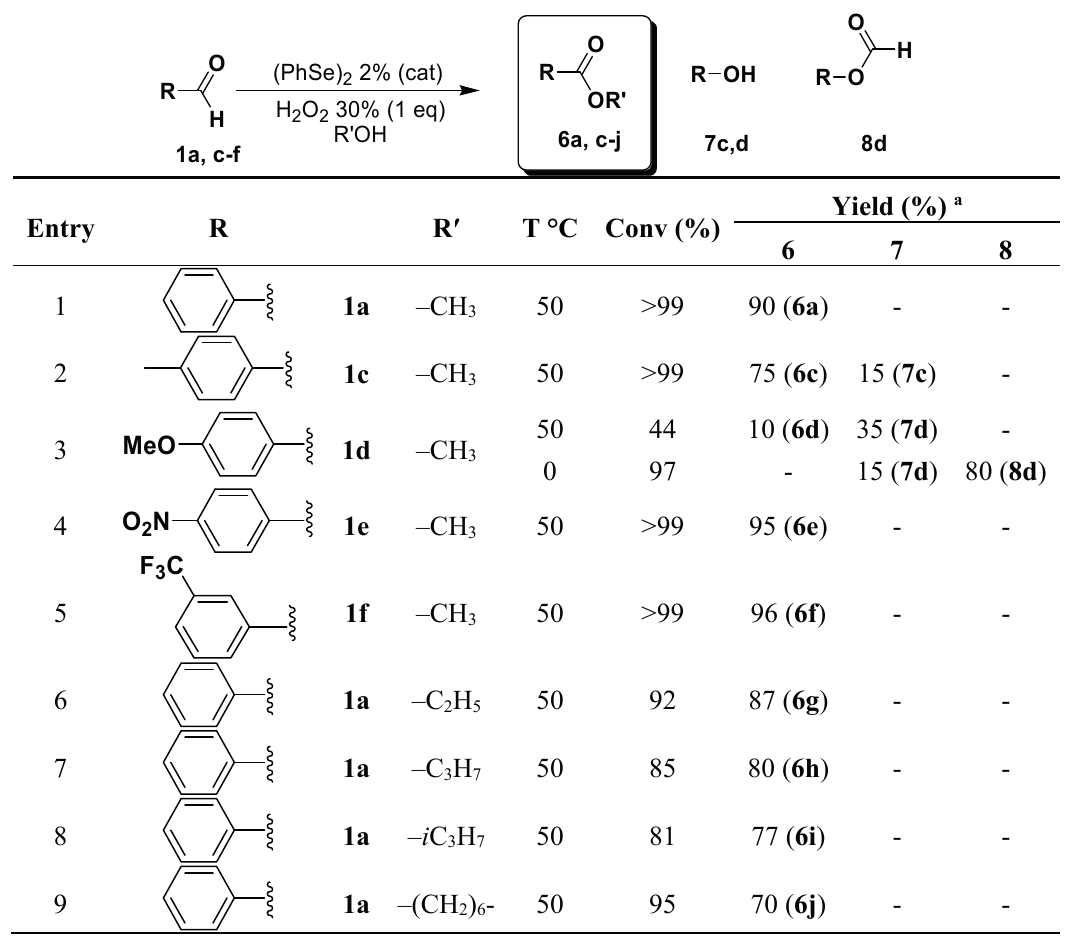
Table 4. Esterification of